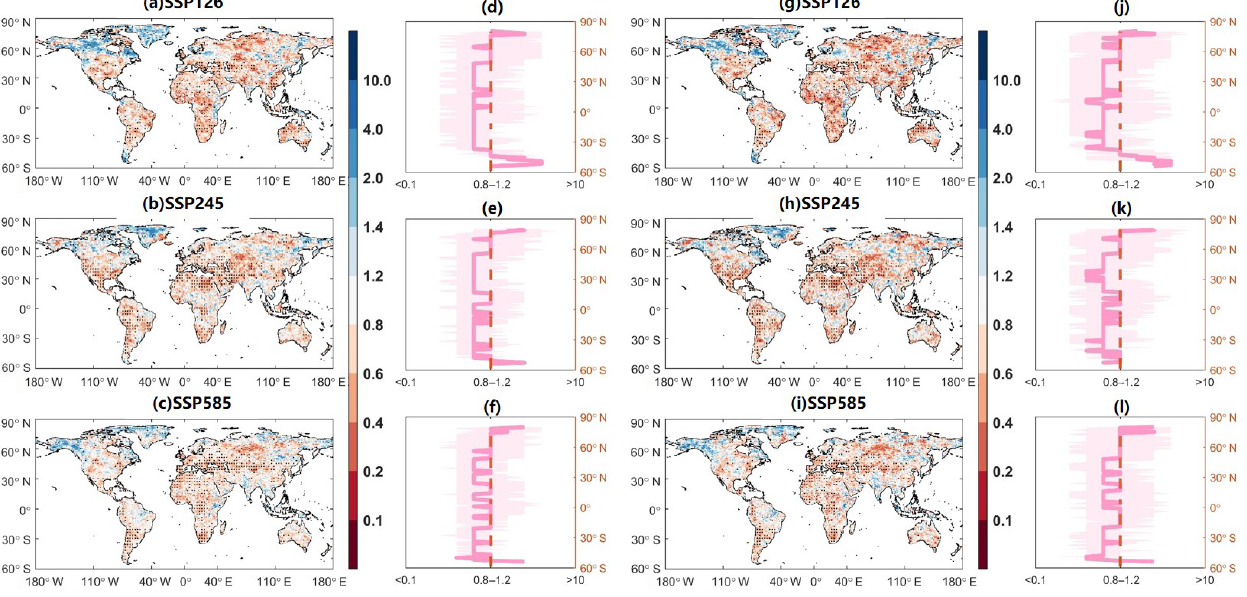
Figure 15. Projected changes in joint 50-year return periods of droughts when using − 0 . 5 as the threshold and − 0 . 8 as the threshold between the 1.5 and 2.0 ◦ C warming targets.